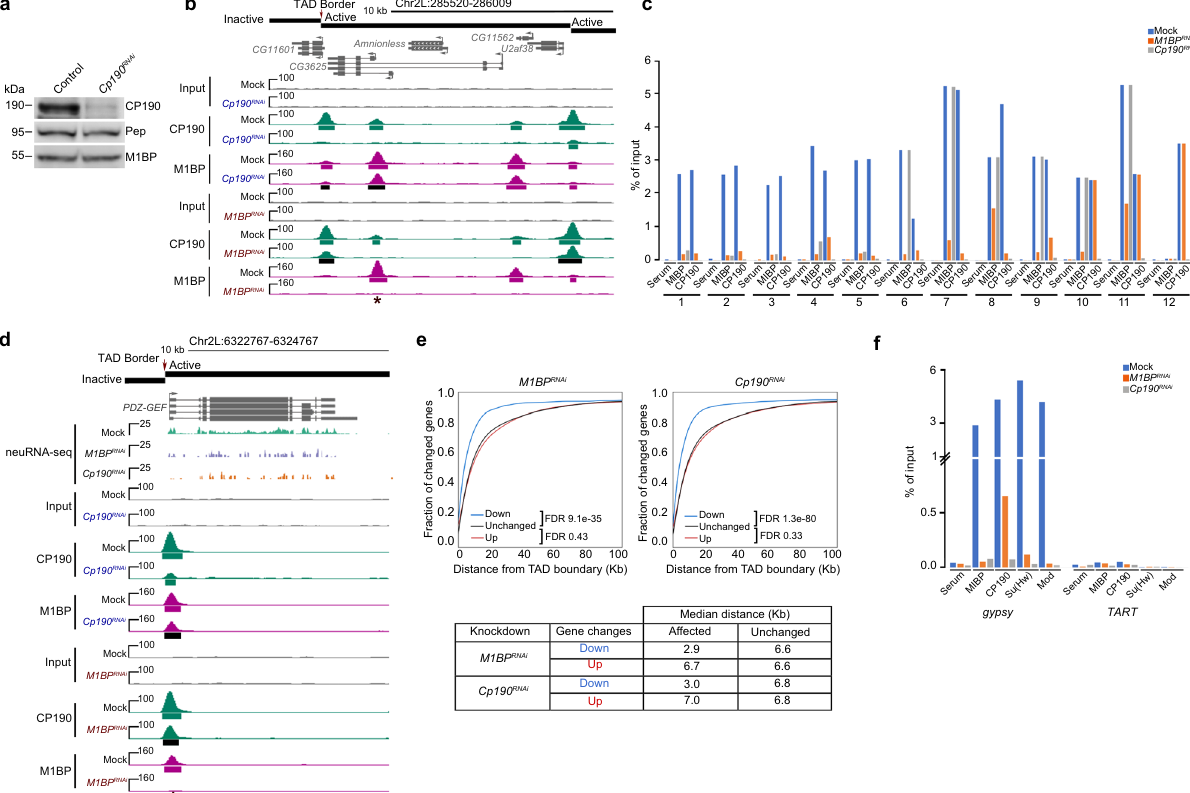
Fig. 6 M1BP association with chromatin is facilitated by CP190 at a subset of sites. a Western blotting of total lysates from Kc control and Cp190 knockdown cells with Pep used as loading control. This experiment was performed for three independent biological replicates with similar results. b Example screenshot of ChIP-seq pro fi les for lost CP190 peak in M1BP RNAi and lost M1BP peak in Cp190 RNAi are shown. Asterisk indicates the particular interdependent peak measured in ( c ), site 1. Called ChIP-seq peaks in either knockdown condition shown in black are signi fi cantly decreased in the knockdown of the opposite factor. c Differentially bound M1BP and CP190 ChIP-seq peaks in M1BP knockdown and Cp190 knockdown validated by ChIP- qPCR. Validation of selected differentially decreased peaks of M1BP and CP190 (sites 1 – 5) and negative control sites (sites 10 and 11). Validation of decreased peaks of CP190 (sites 6 – 9) and negative control site 12. Percentage input chromatin DNA precipitated is shown for each primer set, and average values from n = 2 biological replicates measured using four technical replicates are plotted. Detailed description of each site labeled is summarized in Supplementary Table 5 and C t values are available in Source Data 7. d Example screenshot showing promoter association of M1BP and CP190 is interdependent for downregulated genes in either knockdown of M1BP or Cp190 . In most cases, both proteins localize at TAD borders. For simplicity, only replicate 1 of mock, M1BP RNAi , and Cp190 RNAi is shown for neuRNA-seq tracks. e Cumulative histograms of promoter distance from closest TAD border classi fi ed by change in nascent expression in M1BP (left) or Cp190 (right) knockdown cells. Downregulated (blue), upregulated (red), or unchanged (black) genes are indicated. Table indicates the median distance from closest TAD border for down- and upregulated genes compared to unchanged genes in either knockdown condition. Mann – Whitney U test for each set of changed genes against unchanged genes are shown. Analysis of TADs classi fi ed by chromatin state is shown in Supplementary Fig. 6. f Percentage of precipitated input chromatin DNA from ChIP- qPCR of M1BP, Su(Hw), Mod(mdg4)67.2, and CP190 at Su(Hw)-binding sites of gypsy or TART transposon sites as a negative control in Kc cells either mock-treated or subjected to M1BP RNAi or Cp190 RNAi . Average of n = 2 biological replicates measured using four technical replicates are plotted. C t values are provided in Source Data algorithm, we identi fi ed 2018 CP190 peaks (25% of total) that